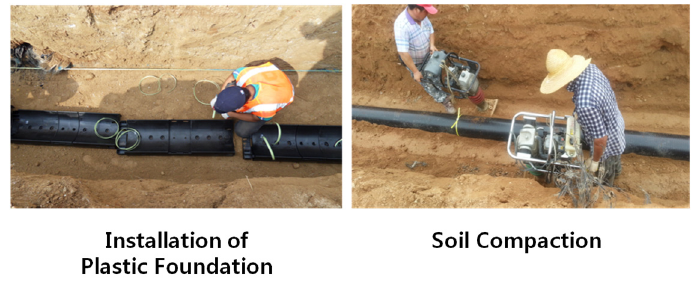
Figure 15. Second field construction for new